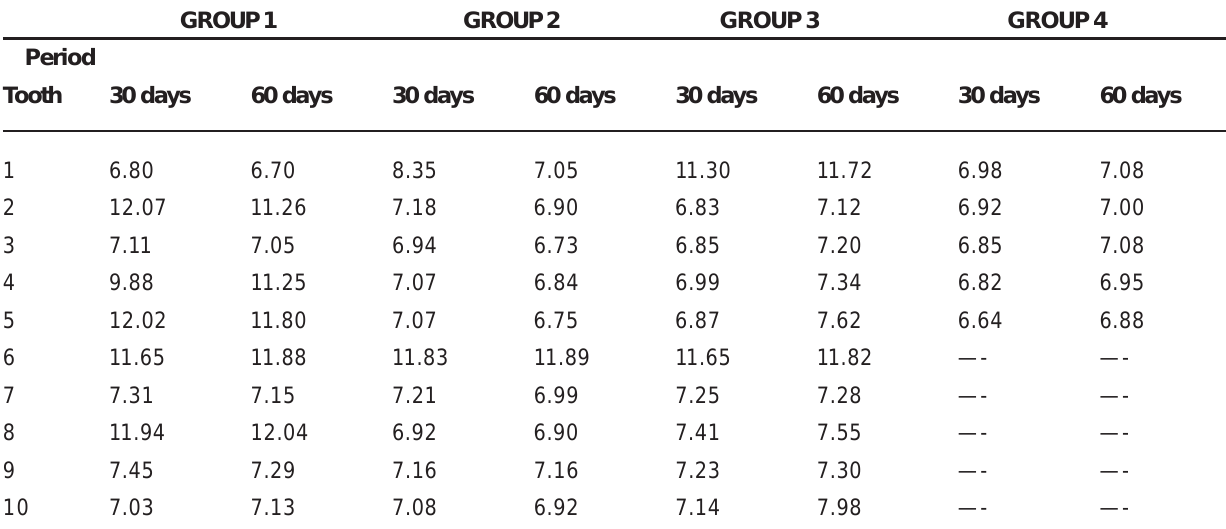
TABLE 1- Measurement of pH of water in contact with teeth in Groups 1, 2, 3 and